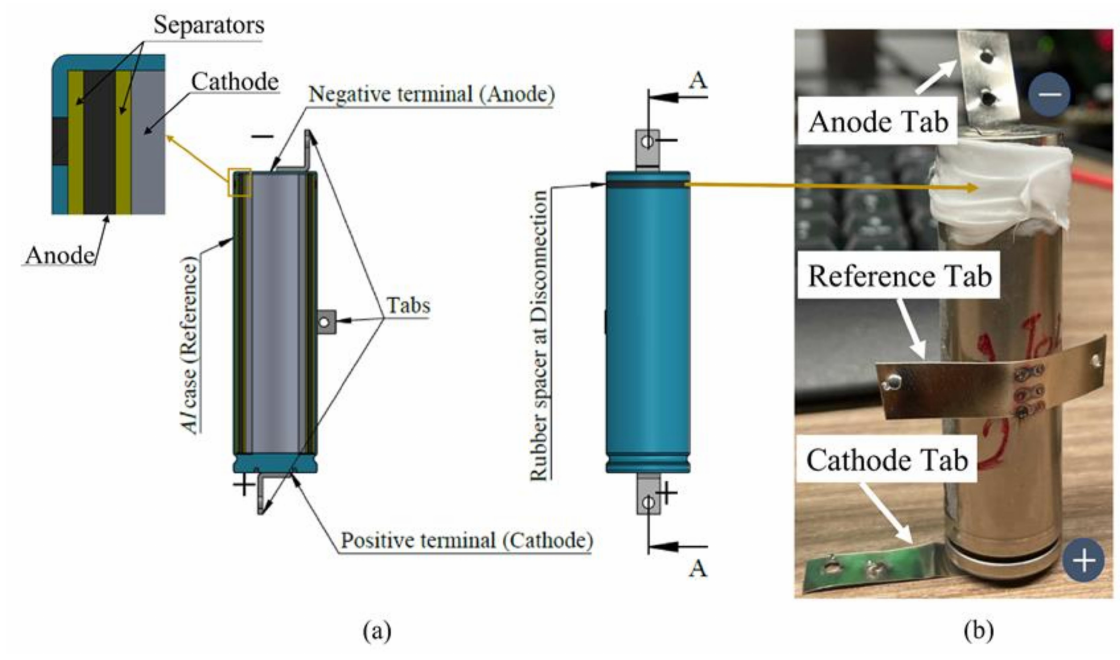
Figure 2. Experimental setup of a three-electrode cell. ( a ) schematic of battery casing-based three electrode cell. ( b ) modified battery cell. Reproduced from [1] with the permission of Elsevier. Copyright